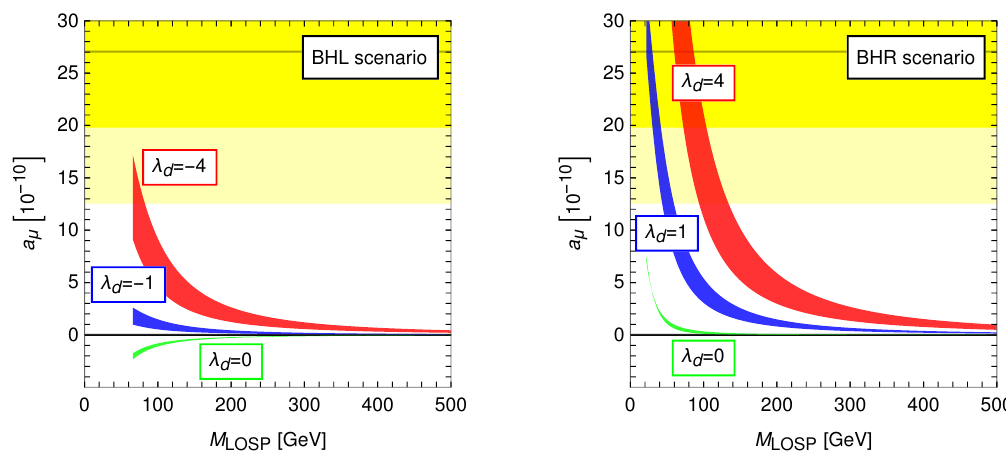
Figure 5. a (cid:22) in the BHL and BHR scenarios. In each plot, the colours of the bands correspond to di(cid:11)erent values of (cid:21) d as indicated; the width of each band corresponds to a variation of the slepton masses by a factor 1 : 5: the borders of each band correspond to the choices m ~ = 1 : 5 m SUSY . The dark and light yellow horizontal bands correspond to the 1 (cid:27) and 2 (cid:27) bands given by eq. (3.3).